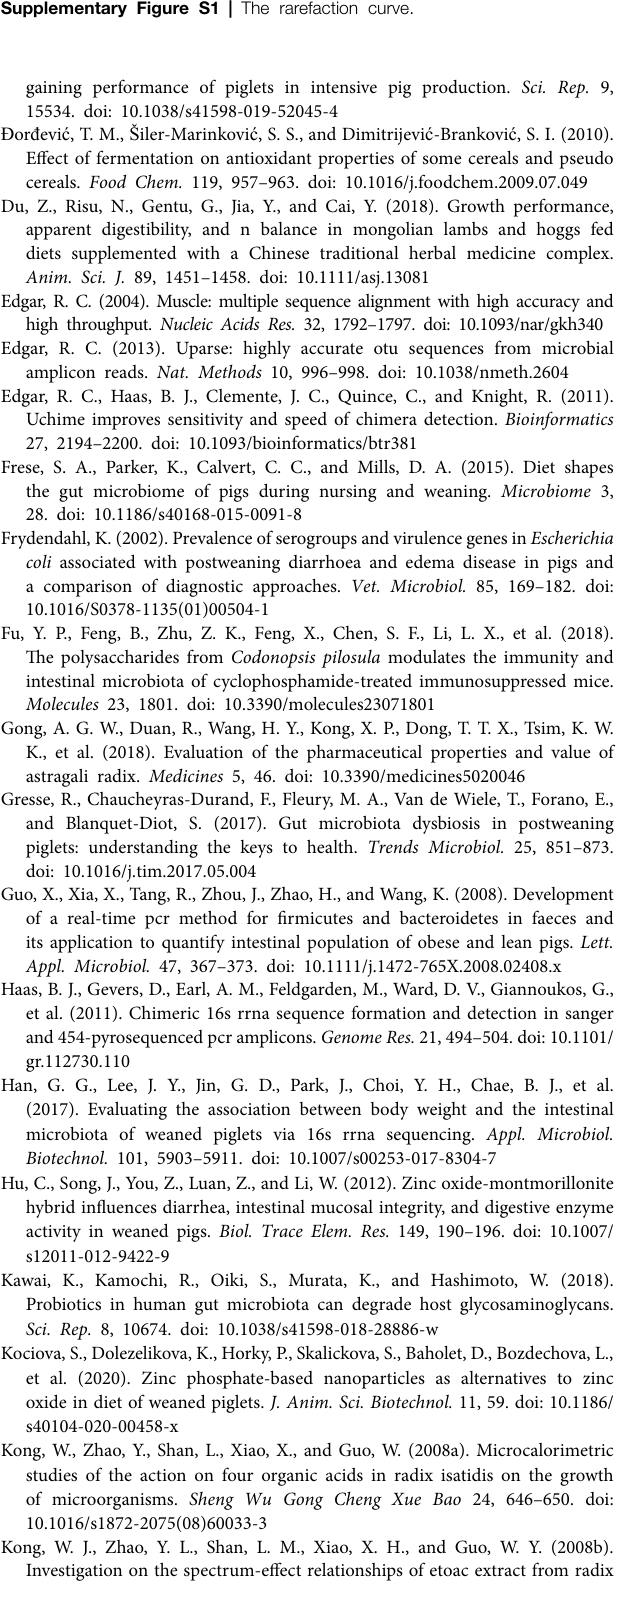
Supplementary Table S3 | Summary of sequencing data of each sample. Supplementary Figure S1 | The rarefaction